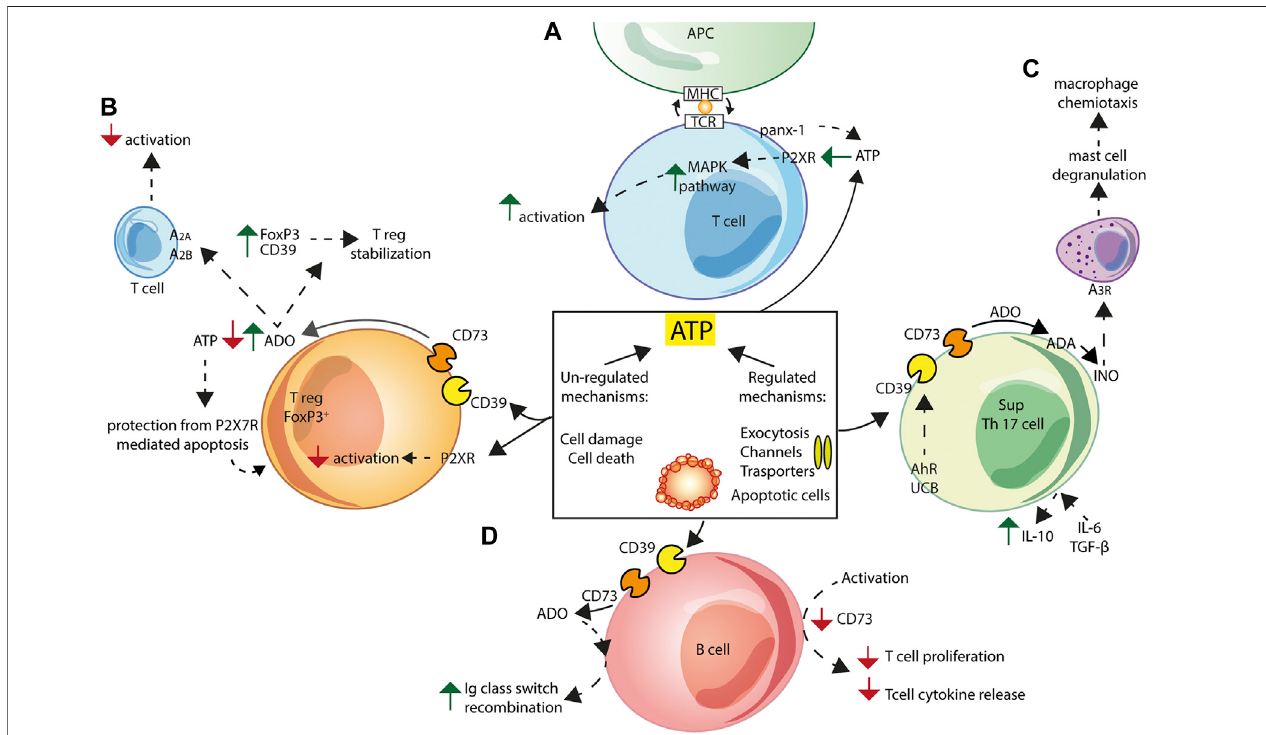
FIGURE 4 | Schematic exempli fi cation of purinergic receptor/ectonucleotidase cooperation in the activation/inhibition of the adaptive immune response. ATP can bereleasedintotheextracellularspaceviabothregulatedandnon-regulatedmechanisms. (A) InTcells,pannexin-1(panx-1)andP2XRslocalizeattheimmunesynapse following T-cell receptor (TCR) engagement. ATP released via panx-1 triggers P2XRs activation leading to increased MAPK signalling and T cell activation. (B) Treg Foxp3 + cellsgenerationandfunctionareinhibitedbyATP-mediatedP2XRssignalling.Adenosine(ADO)formedbyTregNTPDase1/CD39andNT5E/CD73activity causes Treg cells stabilization, by increasing expression of Foxp3 and NTPDase1/CD39, and inhibits T cells responses acting at A 2A and A 2B adenosine receptors. Finally, Tregs are protected from P2X7R-mediated apoptosis thanks to extracellular ATP scavenging by NTPDase1/CD39 and NT5E/CD73. (C) Non-pathogenic Th17 cells express NTPDase1/CD39 and NT5E/CD73, and, following IL-6 and TGF- β stimulation, secrete IL-10, thus showing the typical Th17 suppressor cell (SupTh17) phenotype. NTPDase1/CD39 expression by Th17 lymphocytes is enhanced following exposure to aryl hydrocarbon receptor (AhR) agonists, such as unconjugated bilirubin(UCB).EnhancedSupTh17adenosinedeaminase(ADA)activityacceleratesconversionofadenosinetoinosine(INO),whichactivatestheA 3 adenosinereceptor onmastcells,thuscausingdegranulationandreleaseofmacrophagechemotacticfactors. (D) HumanperipheralBcellsco-expressNTPDase1/CD39andNT5E/CD73. Invitro activationofBlymphocytesco-culturedwithTlymphocytesdown-regulatesNT5E/CD73expressionandinhibitsTcellproliferationandTcell-dependentcytokine release. Extracellular adenosine contributes to immunoglobulin (Ig) class switch recombination in human naïve and IgM memory B cells.